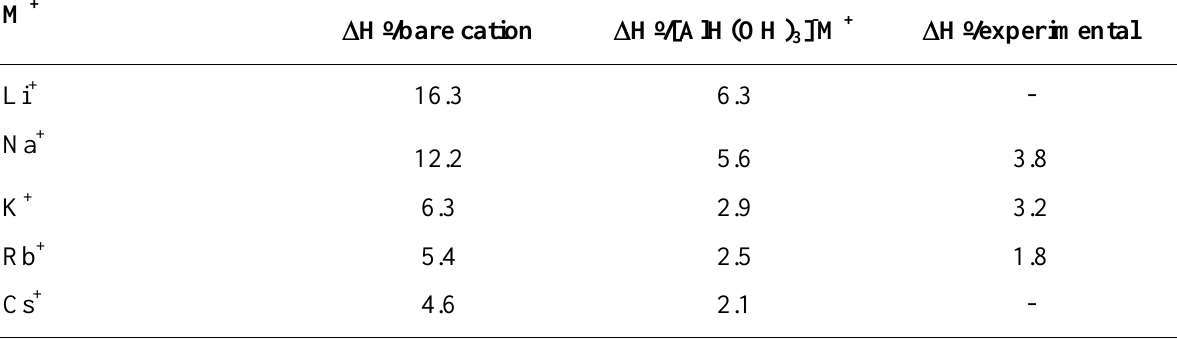
Table 2. Enthalpy change (kJ mol -1 ) in the isomerization process ZM(CO) + ⇆ ZM(OC) +